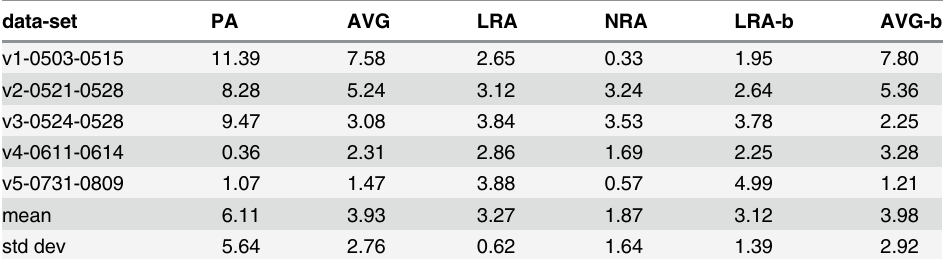
Table 3. Percentage change in mean ADC Δ D % from the two mean ADC values for each volunteer (using Table 4); methods include protocol A and the corresponding average slice using protocol B with and without motion correction; the two bottom rows give the mean reproducibility and standard deviation (within population variability) for each method. data-set PA AVG